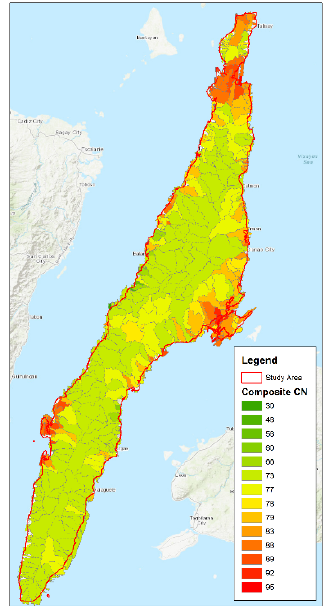
Figure 5. Composite Curve Number Map (AMC II) The curve numbers ranged from 30 to 95. These values represented the runoff potential of a catchment. Higher curve numbers suggest a high potential for runoff. The maximum curve